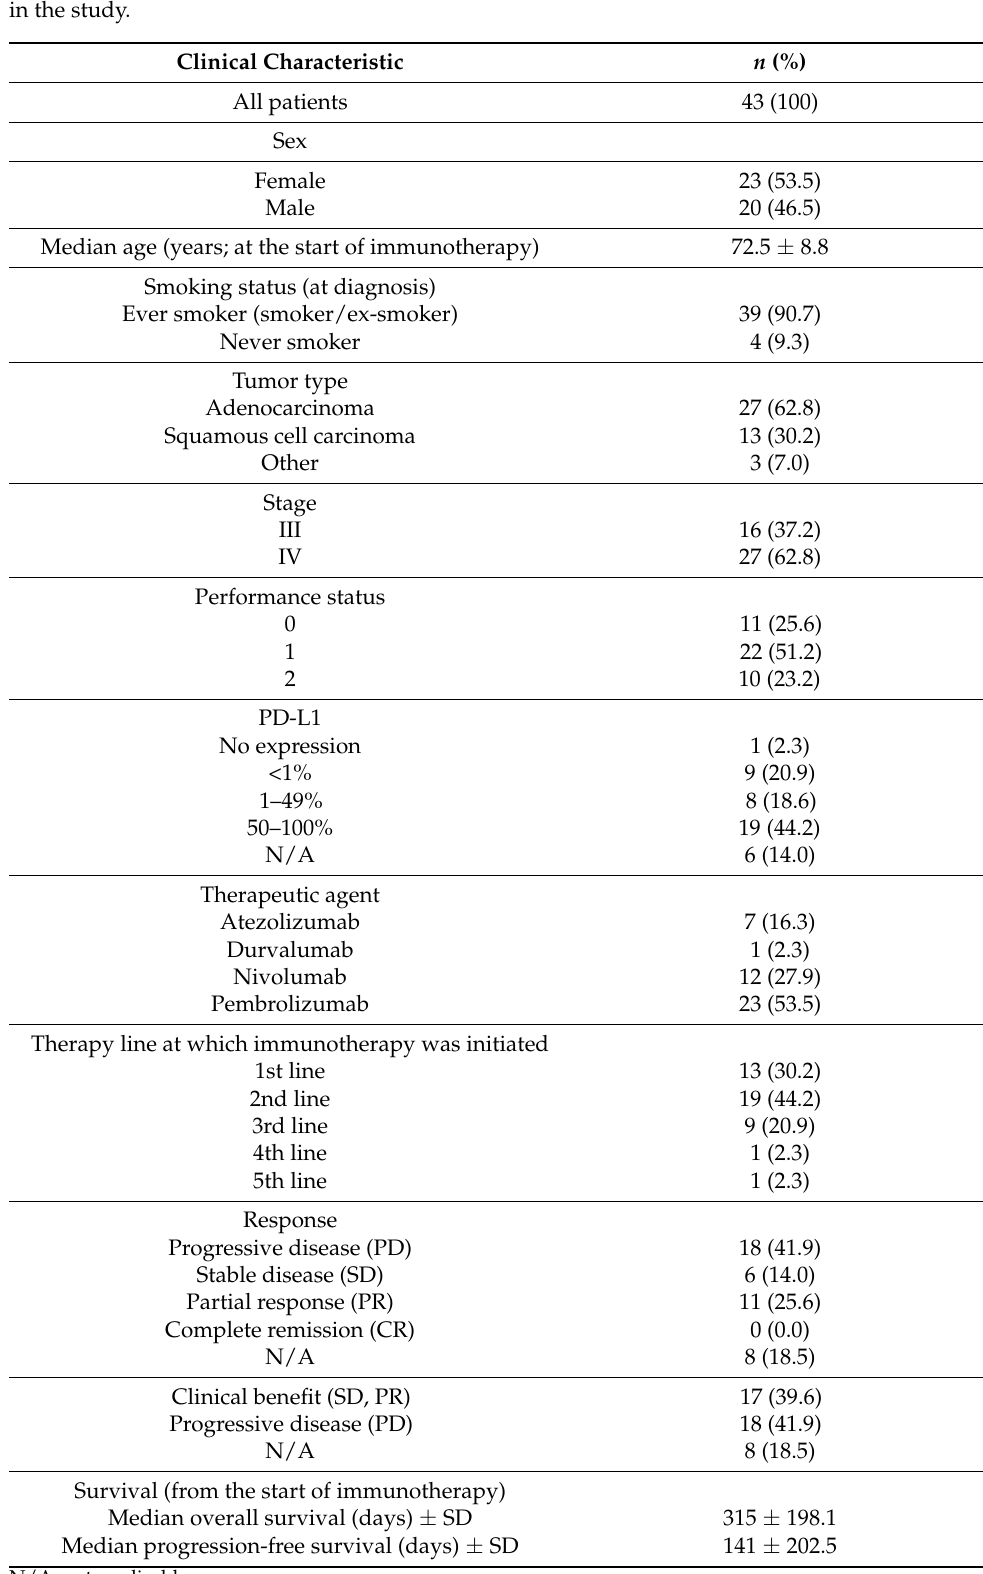
Table 1. Demographic and clinical characteristics of the advanced NSCLC patient cohorts included in the